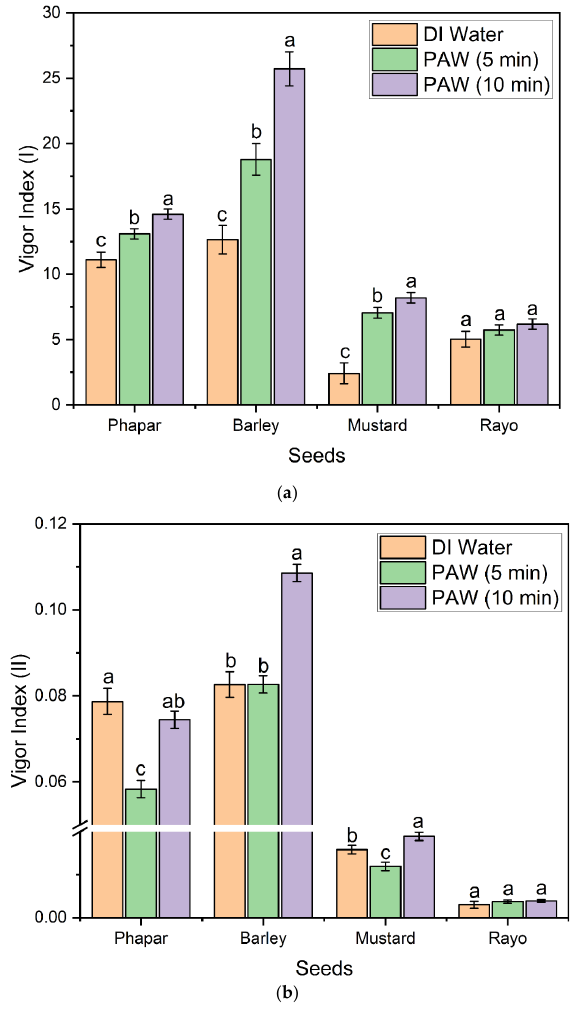
Figure 14. Estimation of ( a ) Vigor I and ( b ) Vigor II of seeds. Different letters (a–c) indicate significant differences at p < 0.05 level among all treatments as determined by Tukey’s multiple comparison test.